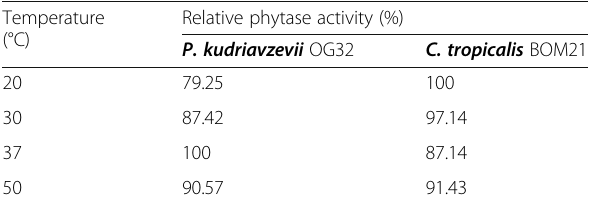
Table 2 Stability of extracellular phytase from yeast strains at different